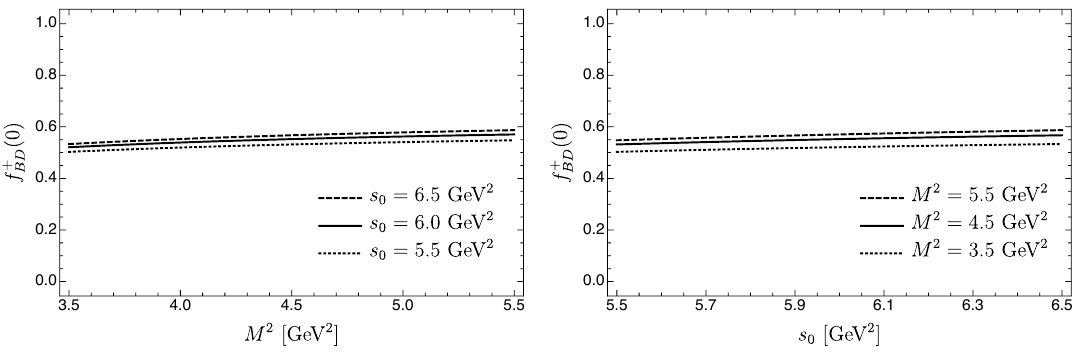
( q 2 = 0) dependence on the Borel parameters M 2 and s BD